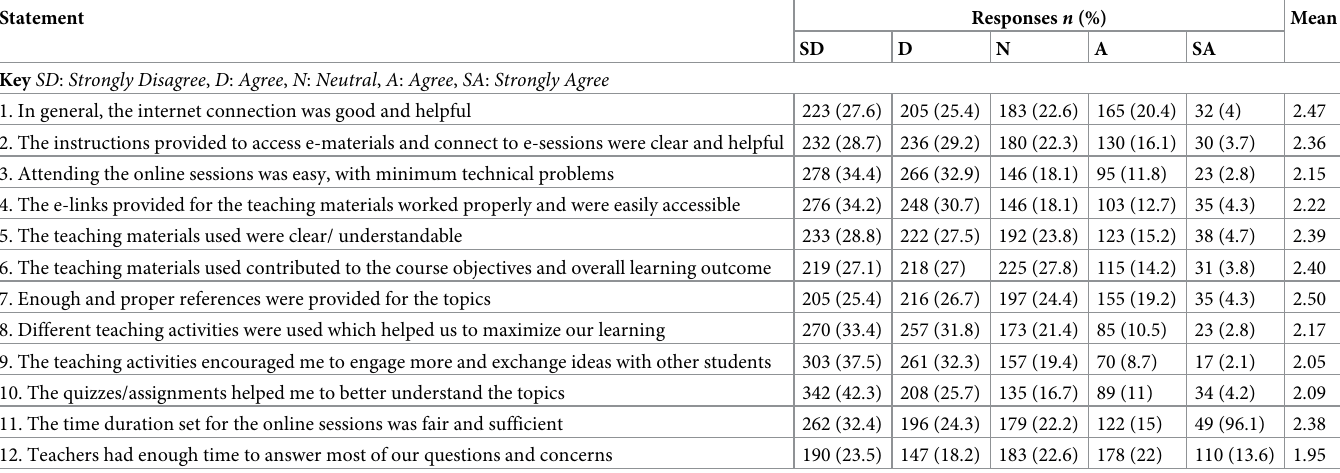
Table 4. Processual stage/statements about e-learning ( n =